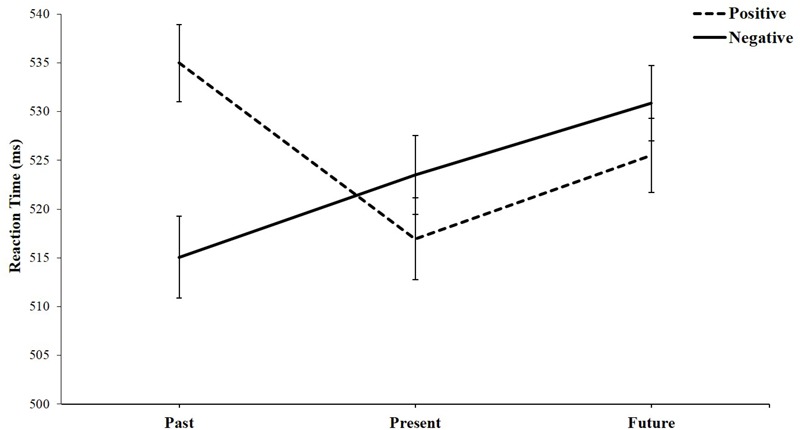
Reaction times (ms) of hit responses as a function of attribute valence and temporal selves.